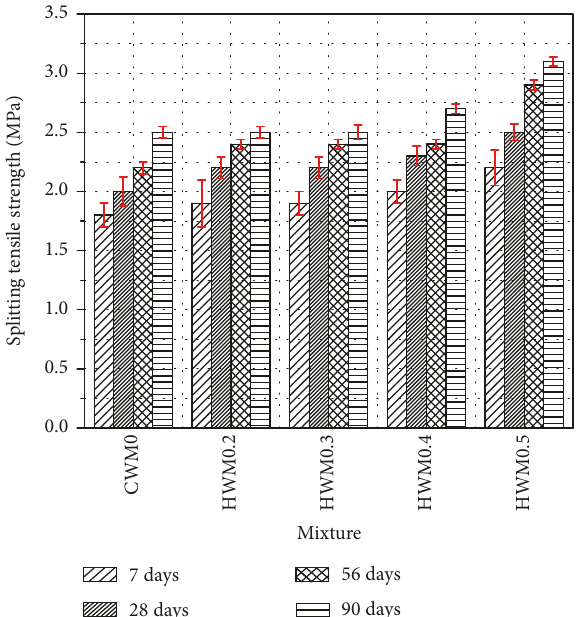
Figure 3: Variation in the splitting tensile strength of mortar mixtures with age.